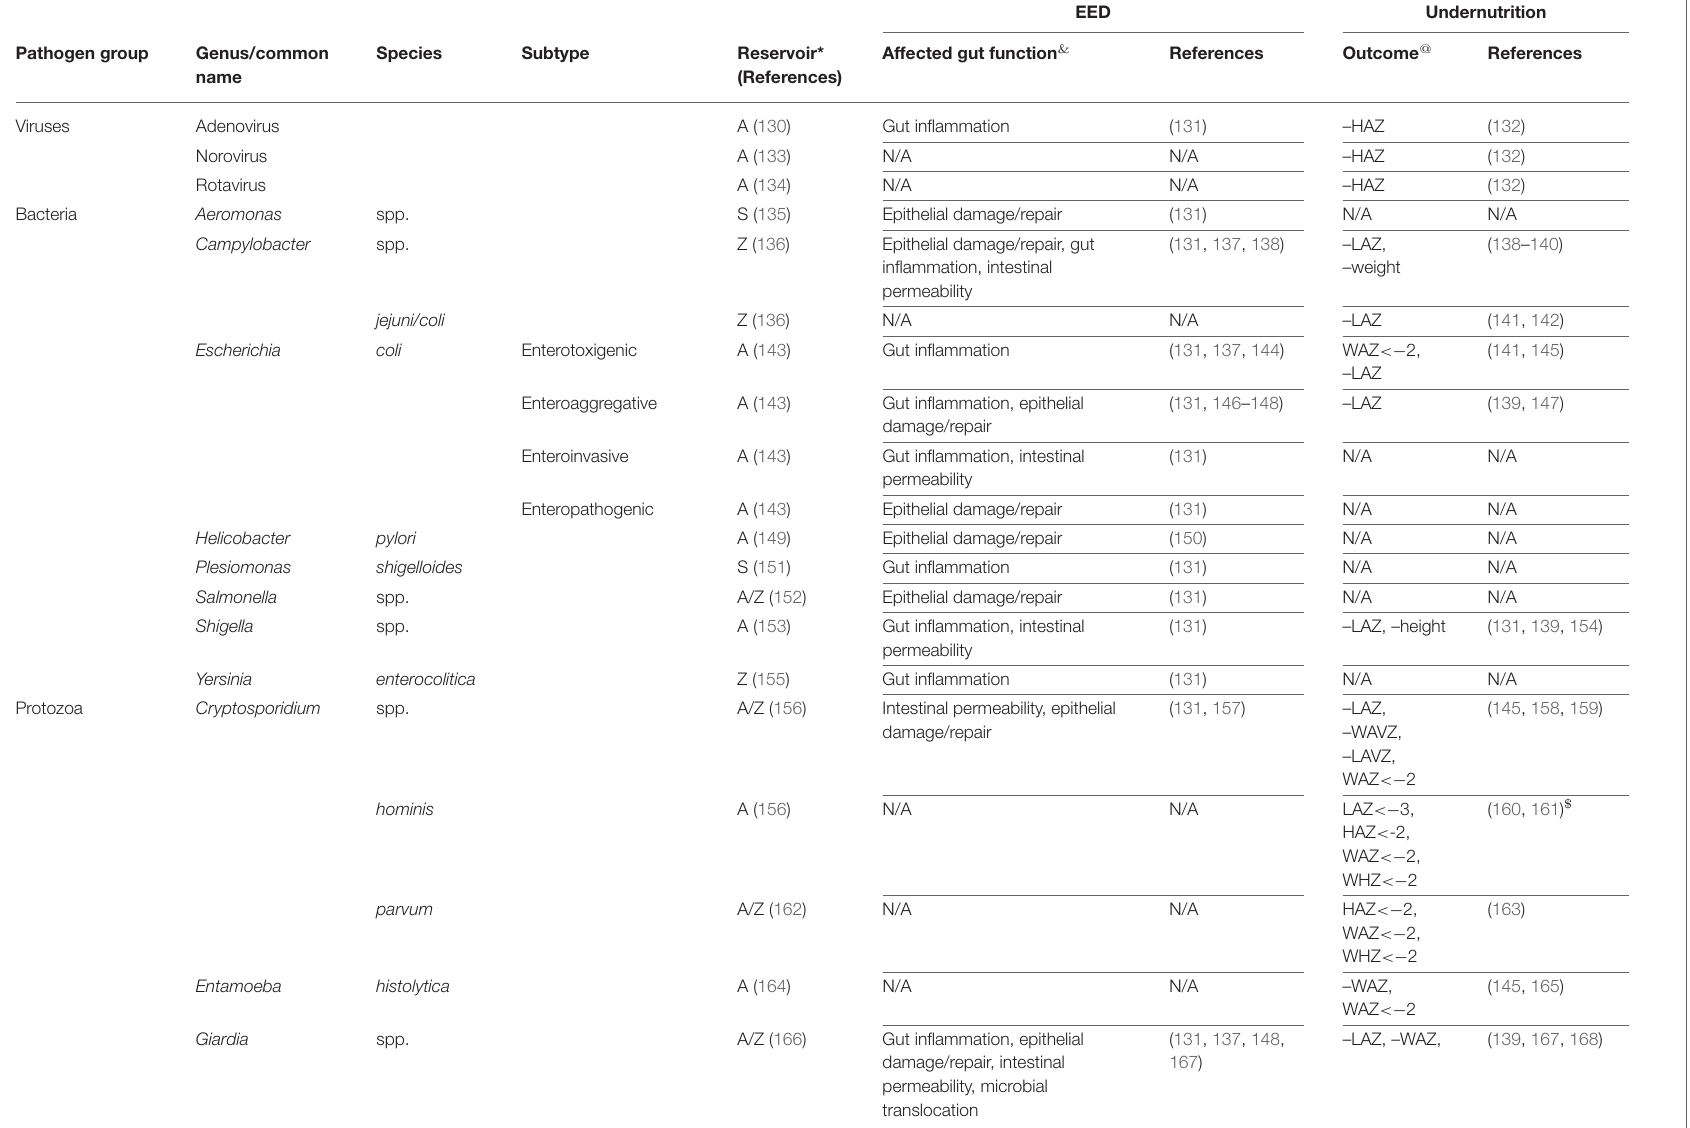
TABLE 2 | Enteric pathogens associated with increased risk of EED or undernutrition at the 95% confidence